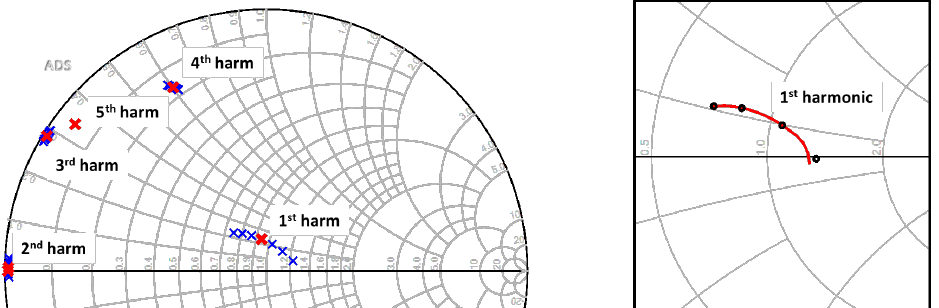
Figure 7. ( Left ): Spread of the S 11 parameter with SiN thickness variations prescribed by the technology PDK. Red crosses correspond to the nominal SiN thickness of 100nm, blue dots to ± σ , ± 2 σ , ± 3 σ where σ = 2nm [41]. ( Right ): Interpolated S 11 at the fundamental frequency (red) compared to EM simulations at 4 test SiN thickness values different to the extraction ones (92nm, 97nm, 103nm, and